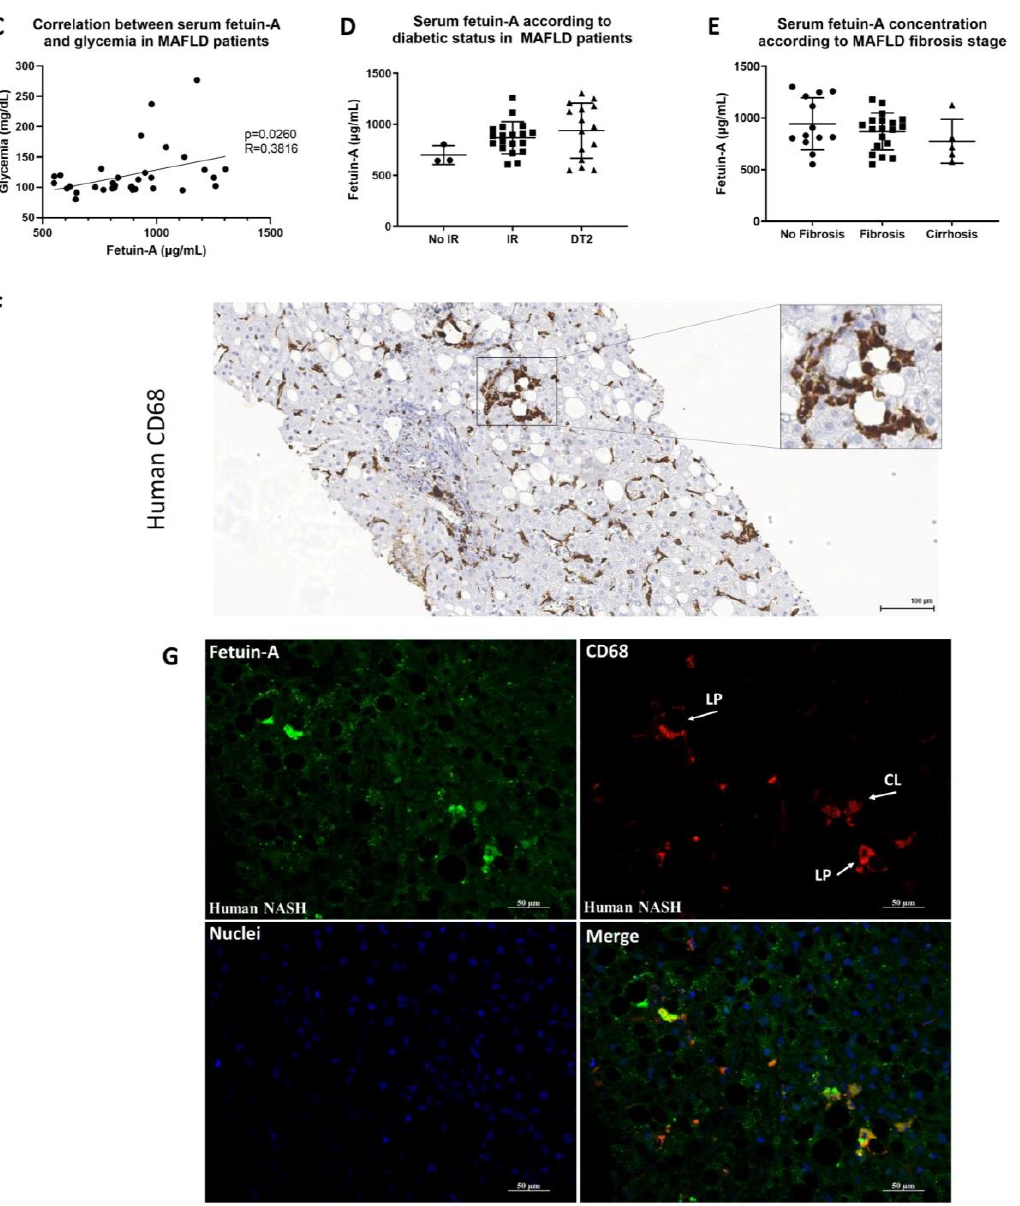
Figure 5. Characterization of fetuin-A in human metabolic dysfunction-associated fatty liver dis- ease. Comparison of liver and adipose tissue (AT) expression of fetuin-A (mRNA) in humans with metabolic dysfunction-associated fatty liver disease (MAFLD). RPL19 served as endogenous control ( n = 5/group), ** p < 0.01 ( A ). Western blot comparison of liver, adipose, and serum fetuin-A content. The corresponding quantification is calculated on the basis of the averages of the ratios of the labelling intensities of fetuin-A corrected by those of actin (endogenous control) ( n = 4/group) ( B ). Correlations between serum fetuin-A levels and glycaemia in MAFLD patients ( C ). Serum fetuin-A levels in MAFLD patients: HOMA < 2.5 ( n = 3), HOMA > 2.5 ( n = 18), or patients treated for type 2 diabetes (DT2) ( n = 16) ( D ). Serum fetuin-A levels in MAFLD patients with no fibrosis ( n = 13), fibrosis ( n = 20), or cirrhosis ( n = 5) ( E ). Immunohistochemistry for the macrophage marker CD68 on histological sec- tion of liver biopsy from a patient with non-alcoholic steatohepatitis (NASH). Activated macrophages in the form of clusters and lipogranulomas are visible (inset) ( F ). Immunofluorescence of fetuin-A (green) and CD68 macrophages (red) in a human NASH liver section. Presence of lipogranulomas (LP) and one cluster of macrophages (CL) also positively labelled for fetuin-A ( G